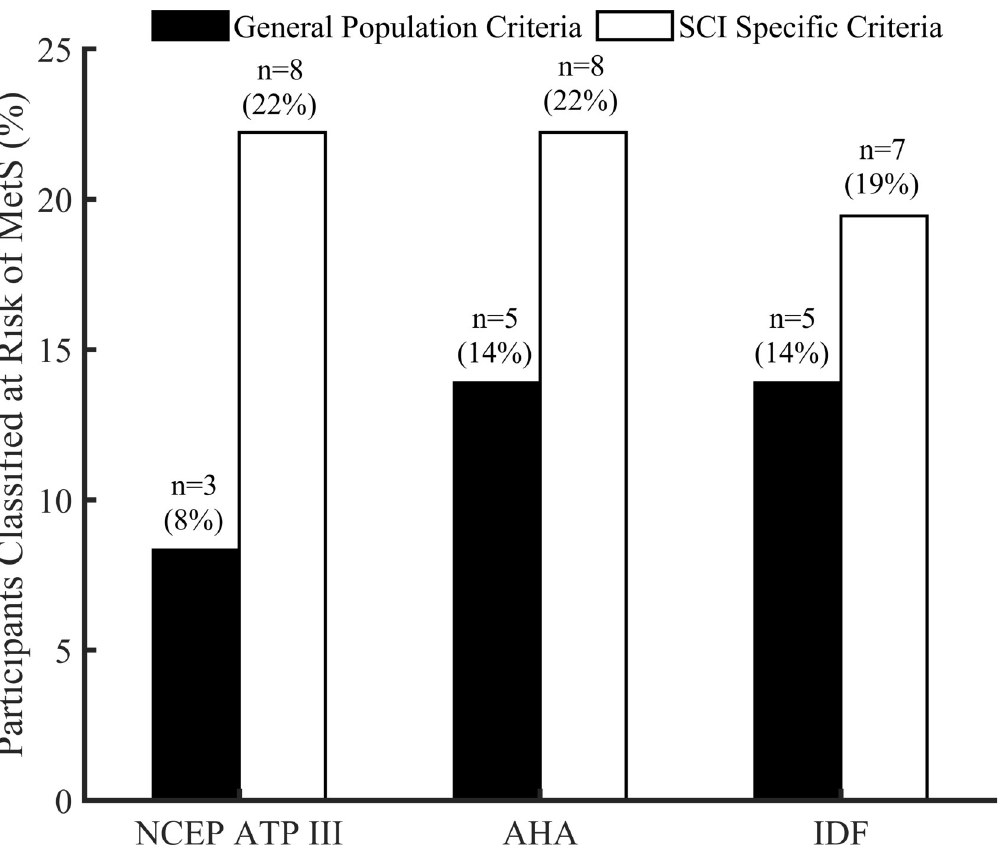
Fig 2. Prevalence of MetS for the three definitions using general population and SCI specific criteria listed in Table 1A and 1B